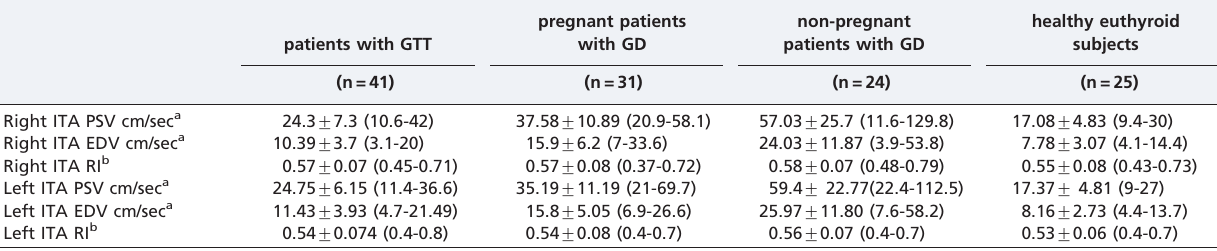
Table 2 - The right and left ITA blood flow velocities of the study participants.